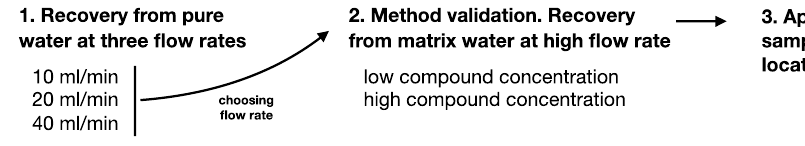
Figure 2. Flow chart illustrating the three main experiments.